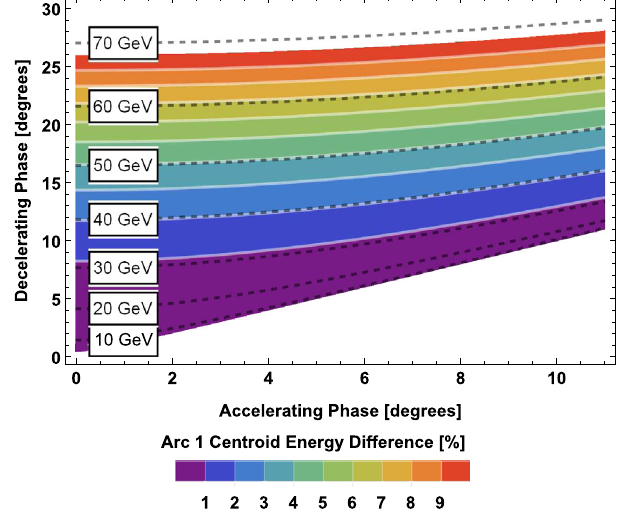
FIG. 9. Arc 1 centroid energy difference between accelerating and decelerating beams for a range of accelerating and deceler- ating phases. Black dashed contour lines represent peak energy in